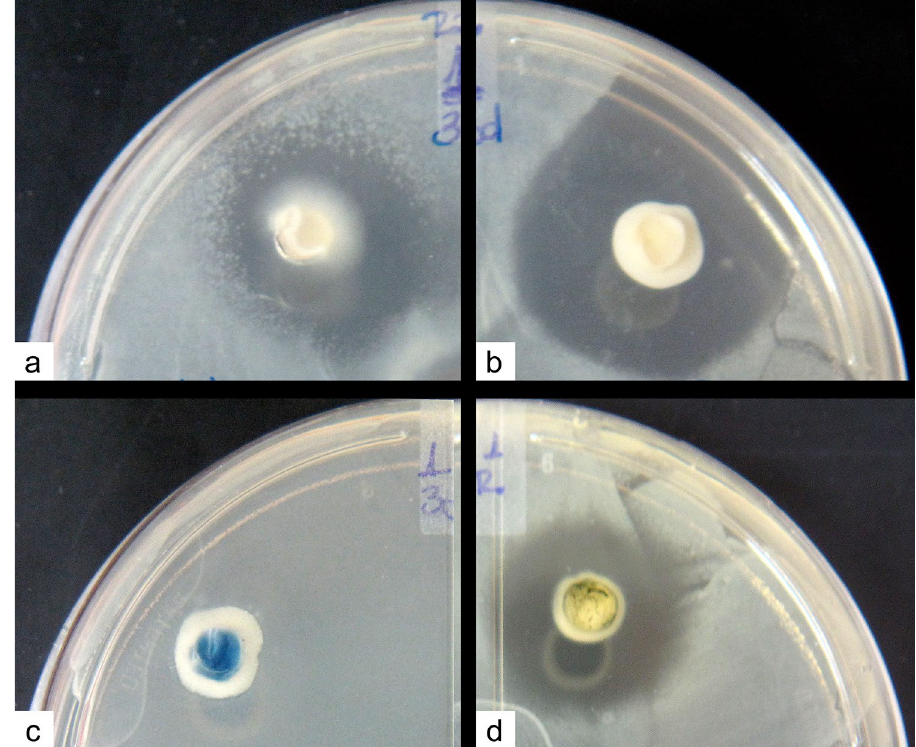
Figure 4. Bacterial growth Inhibition zone produced by fungi plugs exposed to E. coli during 30 days. ( a ) Thelebolus sp. ( b ) Cryptococcus gilvescens . ( c ) Antarctomyces sp. ( d ) Penicillium